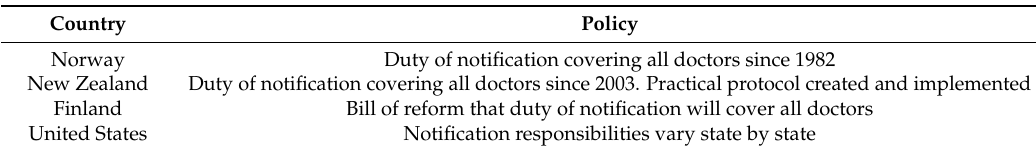
Table 1. Duty of notification policies in different